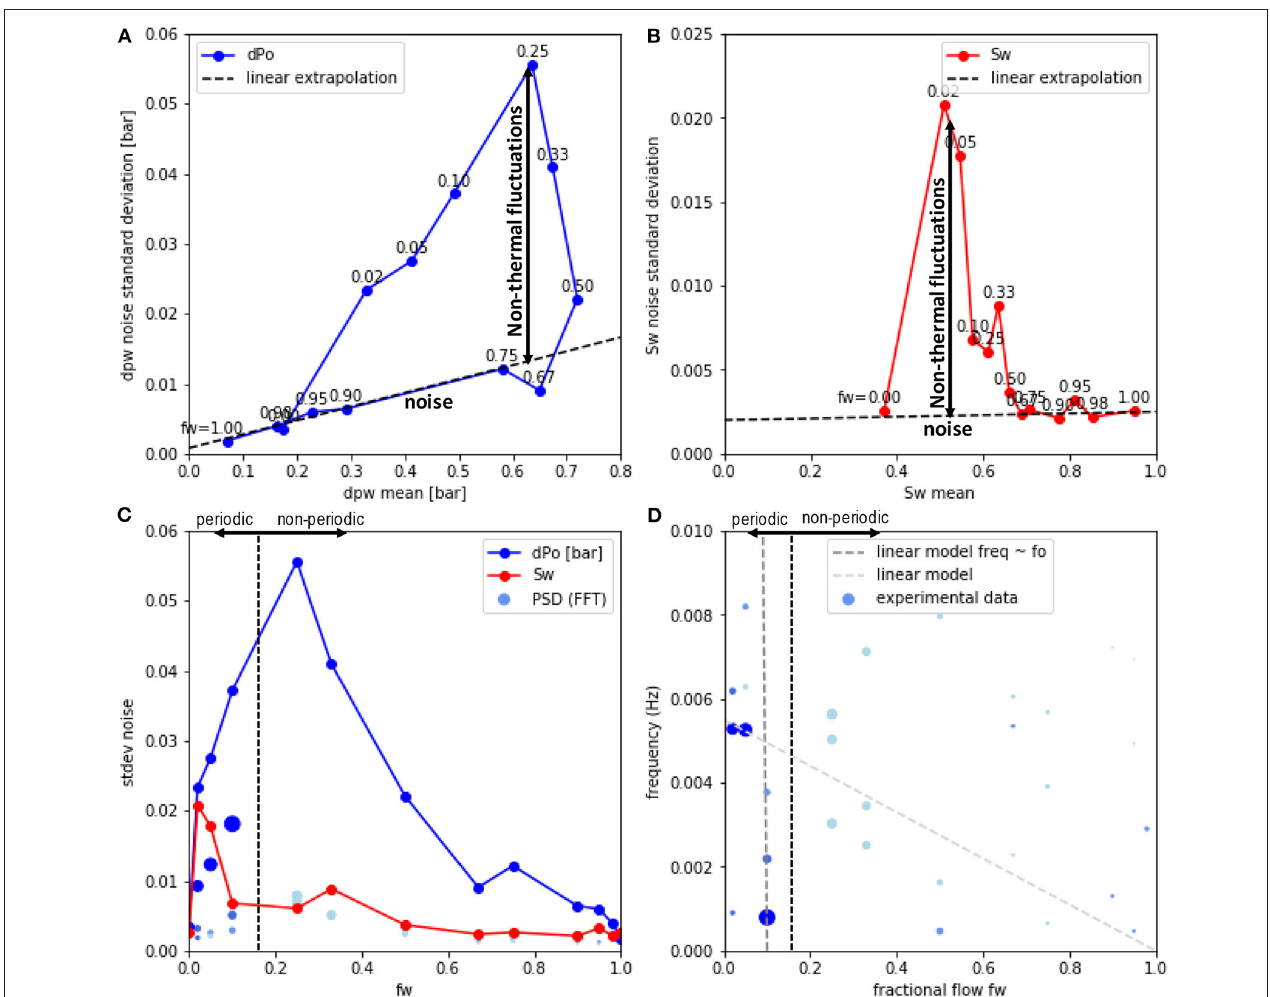
FIGURE 5 | Separating the non-thermal fluctuations from instrumental noise: Standard deviation of the noise for pressure drop (A) and saturation (B) for each f w plateau (added as label for each point) in Figure 2A as a function of the respective mean values for each f w plateau. For the pressure drop 1 p (A) , for f w ≥ 0.67 an approximately linear increase is observed meaning that the pressure fluctuations are proportional to the mean pressure (dotted red line). But at f w < 0.67 the fluctuations are up to more than 3 times the value above the noise. The saturation (B) follows a somewhat similar behavior in the sense that the fluctuations can be much larger than noise. But there is no direct proportionality between pressure and saturation fluctuations. The maximum in fluctuations is observed also for different f w (C) . The periodic fraction of the fluctuations characterized by the PSD of the FFT from Figures 2B–E (dot size represents peak amplitude and color its prominence) shows a somewhat similar trend with f w .Based on the magnitude of the periodic fraction one can divide the fluctuations into a periodic and non-periodic dominated regime. However, the frequency of the dominant peaks in the Fourier spectrum do not show any obvious systematic, e.g., linear dependency on fractional flow (D)